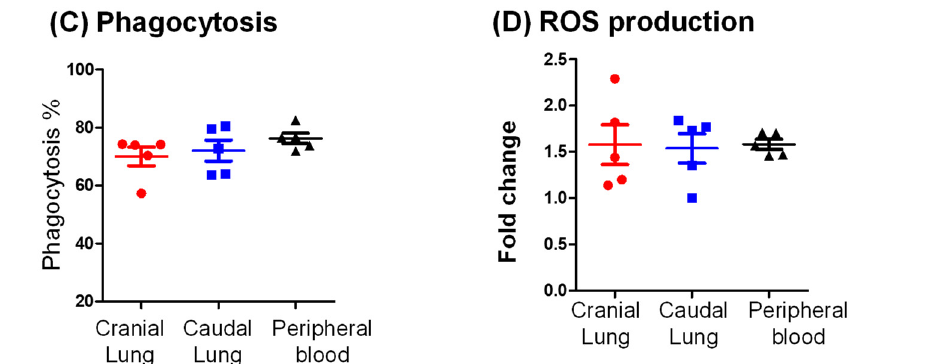
Figure 6. Analysis of the percentage of phagocytic cells and ROS generation by camel lung and blood phagocytes. ( A ) Analysis of phagocytosis by flow cytometry: camel lung cells or blood leukocytes were incubated with FITC-labeled S. aureus and analyzed by flow cytometry. After setting a gate on phagocytes (SSC high FSC high cells) and blood granulocytes (SSC high FSC low cells), the percentage of phagocytic cells was identified based on the elevated fluorescence in the FITC channel. ( B ) Analysis of ROS production by flow cytometry: Camel lung or blood leukocytes were stimulated with S. aureus bacteria or left without stimulation. ROS production was detected after the addition of dehydrorohdamin-123 (DHR-123) by flow cytometry. The amount of ROS production was evaluated based on the increased fluorescence in the FL1 channel (DHR-123 MFI) (representative overlapping histograms from one animal). ( C ) The percentage of phagocytic cells within cranial and caudal lung phagocytes or blood granulocytes was presented graphically. ( D ) The amount of ROS production was calculated as the fold increase in the DHR-123 MFI level in stimulated cells compared to basal ROS level in unstimulated